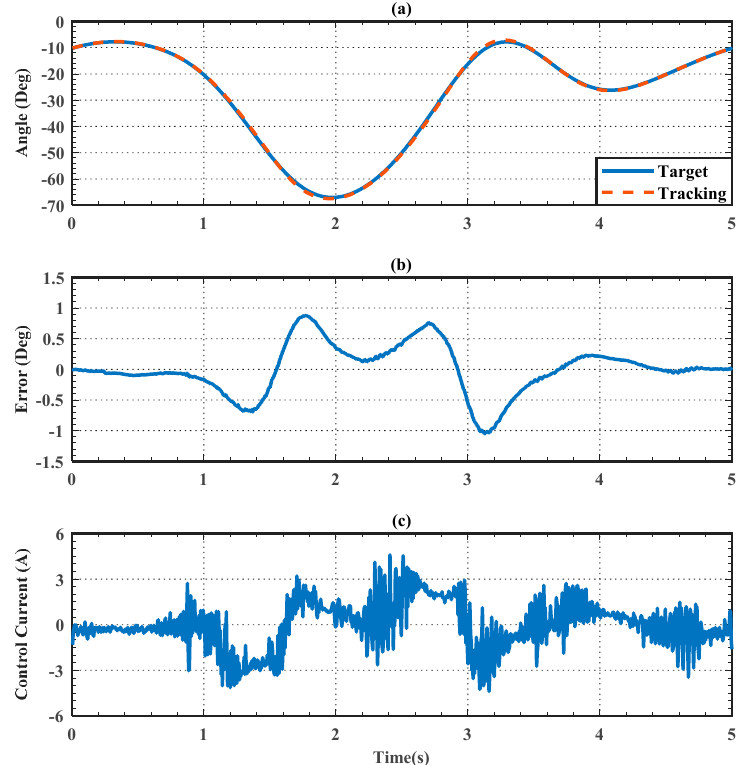
Figure 16. Right knee joint trajectory tracking for LES with the ILESO − PSMC. ( a ) Knee joint angle tracking response; ( b ) knee join angle tracking error; ( c ) current control signal.